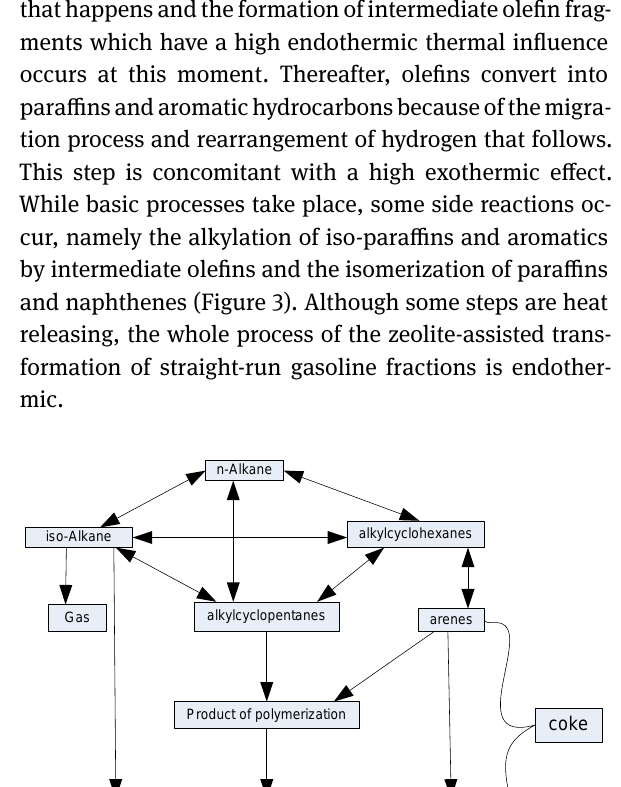
Zeolite catalysts do not need preliminary removal of sulfur or hydrofining and gaseous hydrogen. The